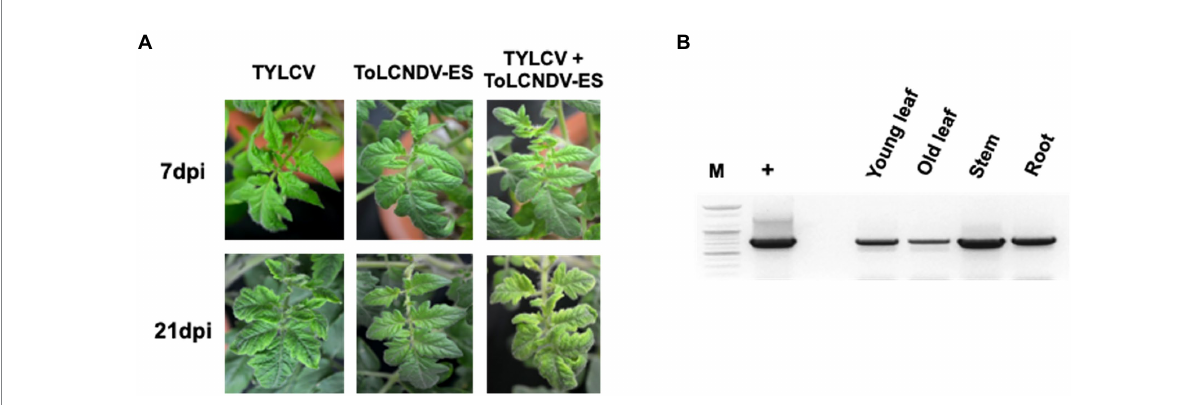
FIGURE 4 ToLCNDV appearance on co-inoculated tomato plants (San Pedro cultivar): (A) phenotype of single and co-inoculated tomato at 7 and 21 dpi. Leaf yellowing symptom was induced in TYLCV and co-inoculated plants, whereas ToLCNDV-ES inoculation displayed a normal phenotype. The symptom severity in co-infected plants was a little higher than a single TYLCV infection; (B) PCR results of ToLCNDV-ES on different organs including young leaf, old leaf, stem, and root of tomato. Lane M: ladder, lane +: positive control, lane − : negative control. DNA A of this virus was found in all tested tissues.